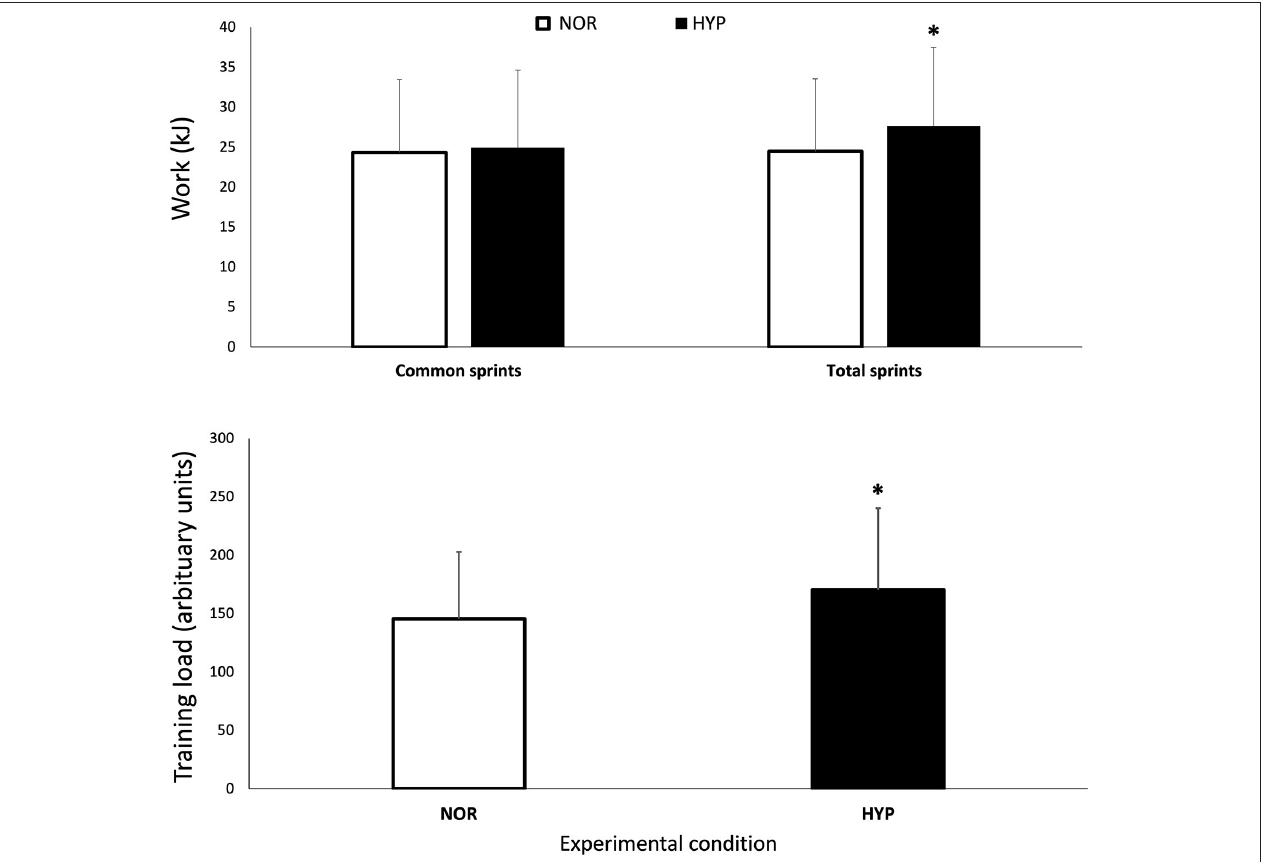
FIGURE 1 | Mechanical work performed over the entire series of sprints (W tot ) and for the same number of sprints performed in both conditions (W com ) session training load over the repeated-sprint ability test in normoxia and hyperoxia (F I O 2 0.40). Data are presented as means ± SD. *Small effect between conditions. W tot values were 24.47 ± 9.1 kJ in NOR and 27.65 ± 9.8 kJ in NYP. W com values were 24.33 ± 9.2 kJ in NOR and 24.91 ± 9.7 kJ in HYP. TL was increased from 139.52 ± 60.49AU in NOR to 169.60 ± 69.88 in